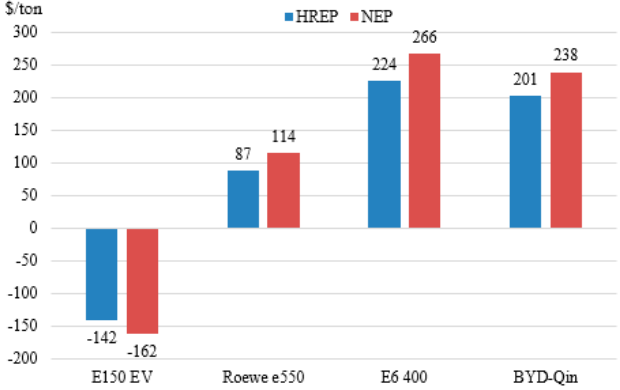
Figure 7. Cost efficiency of substitutions between BEVs or PHEVs and CVs.